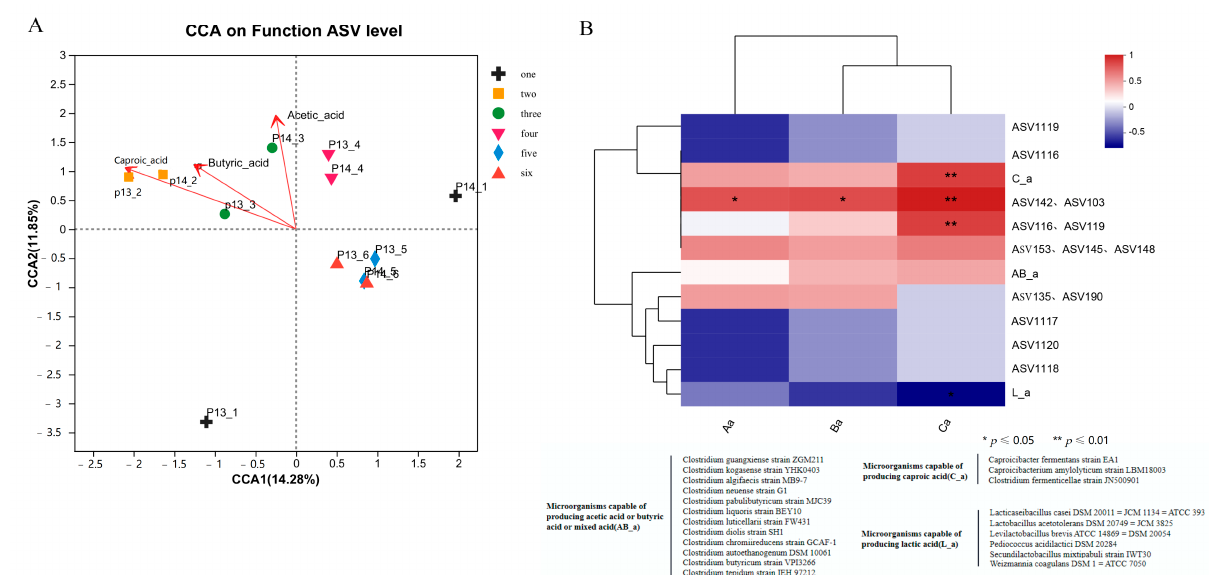
Figure 4. Relationship between microbial community and organic acid composition. ( A ) CCA analysis of functional microorganisms and organic acids. ( B ) Spearman analysis of functional microorganisms and metabolites (Aa: acetic acid; Ba: butyric acid; Ca: caproic acid; C_a: microorganisms capable of producing caproic acid; AB_a: microorganisms capable of producing acetic acid, butyric acid, or mixed acid; L_a: microorganisms capable of producing lactic acid). (more significant difference: * p ≤ 0.05; significant difference: ** p ≤ 0.01).